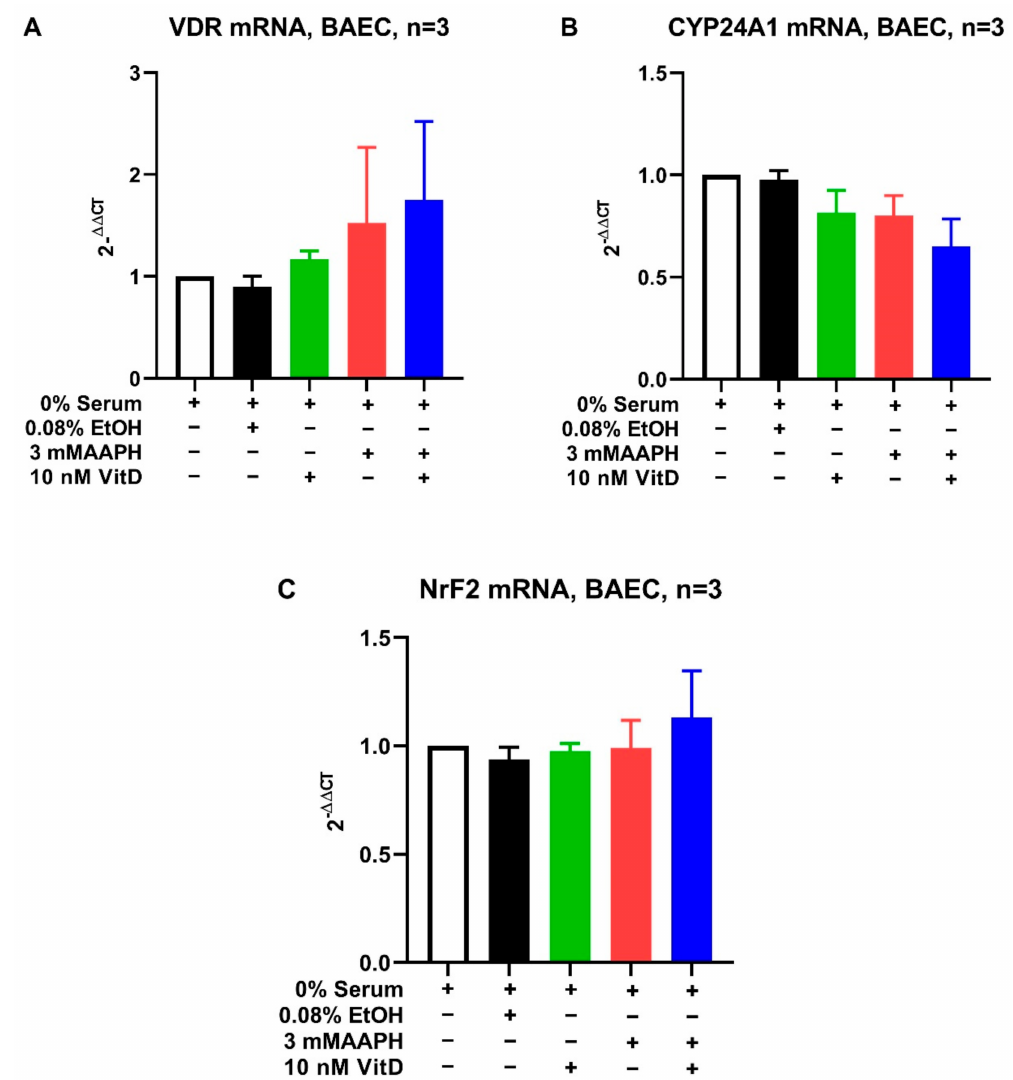
Figure 2. Gene expression in BAEC treated with AAPH with or without vitamin D. The mRNA expression was quantified for vitamin D receptor (VDR, ( A )), cytochrome P 450 24A1 (CYP24A1, ( B )), and nuclear erythroid factor 2 like (NrF2, ( C )) after incubation with treatments for 60 h. The mRNA expression data are presented as fold change relative to untreated controls (open bars). The mRNA expression data for each treatment were compared to untreated control and analyzed by the one-way ANOVA with Dunnett’s post hoc adjustment for multiple comparisons. For all comparisons, α =